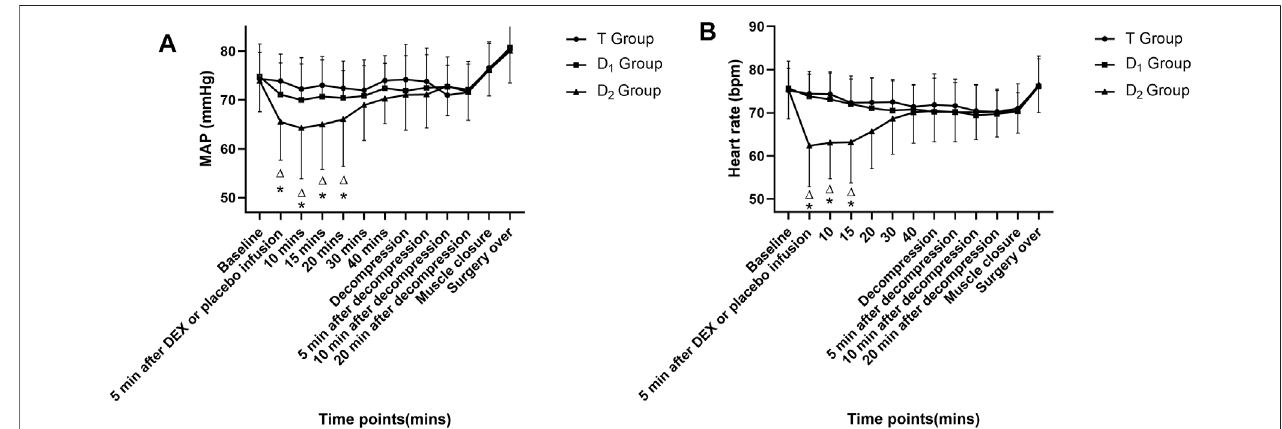
FIGURE3| Time course ofintraoperative mean arterial pressure (MAP)(as depicted in3A) and heartrate(HR) (asdepictedin3B)inthe threegroups. △ Compared with baseline value (after muscle incision, but before dexmedetomidine or placebo infusion) at corresponding time points, p ＜ 0.05; * compared with the T group at corresponding time points, p ＜ 0.05. DEX: dexmedetomidine; the T group: propofol- and remifentanil-based total intravenous anesthesia group; the D 1 group: TIVA combined with dexmedetomidine at a constant infusion rate; the D 2 group: TIVA combined with dexmedetomidine delivered by a loading dose and then by a constant infusion